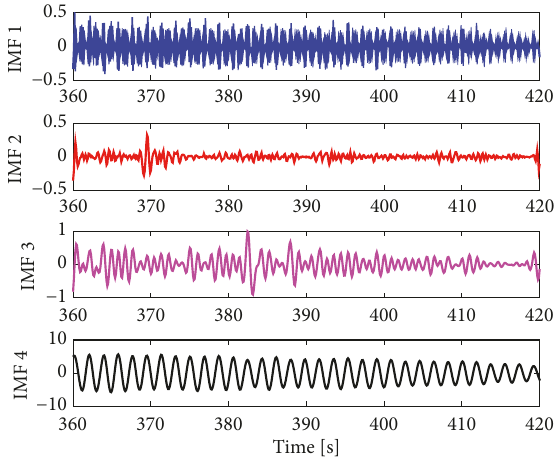
Figure 11: A plot of the first extracted 4 IMFs in the analyzed